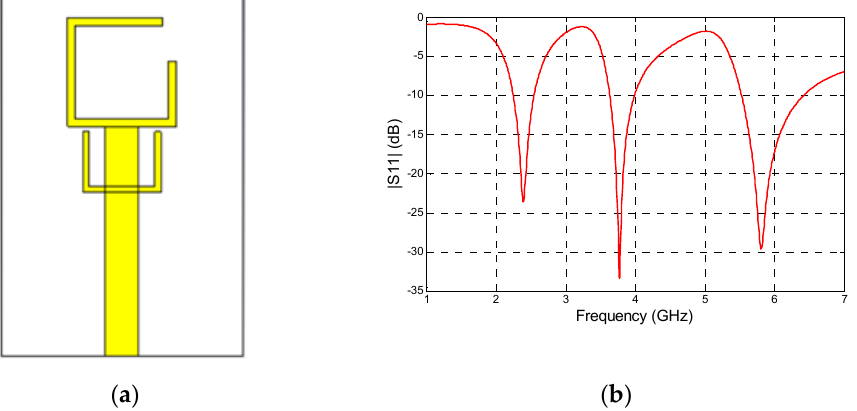
3. Parametric Study For choosing the proper structure of the antenna, the initial design was changed over the development steps process as detailed earlier in Section 2. In this article, a partial ground plane was used for achieving good radiation characteristics and the radiating el- ement consists of a full and half square rings shape that are introduced after starting with the conventional square-shaped patch antenna. Thence, a slot is engraved to get a square ring shape that produces two different bands, and then the ring is converted to a split ring. Finally, a second half ring resonator is adding to produce an antenna with triple-band. Different parameters are optimized according to the parametric analysis to obtain the modified parameters. The most effective parameters on the operation of the proposed de- sign are the width of the SRR and the distance between the two rings. When all parameters are kept constant and varying the width of the split ring resonator (t), Figure 7 shows the effect of this parameter on the first and second resonance frequencies. Both frequencies are shifted to higher values at t = 1.06 mm and at t = 1.41 mm with a little reduction in the reflection coefficient value. Furthermore, at t = 1.41 mm, the second frequency is com- pletely eliminated. Therefore, t = 0.71 mm is selected since it gives the first resonant fre- quency at the 2.4 GHz WLAN and the second at 3.7 GHz WiMax applications with mini- mum reflection coefficient values. The second parameter that affects the response of the reflection coefficient is the distance (d) between the bottom end of the split square ring and the other half ring. This distance affects the location of the third resonant frequency, and it is found that it is located at 5.8 GHz at d = 5.5 mm. However, it is shifted to more than 6 GHz in the other two distance values with a reduction in the return loss